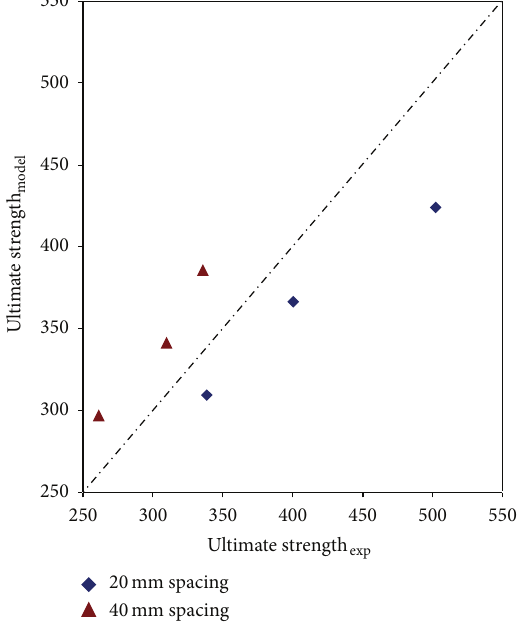
Figure 24: Correlation between experimental and theoretical strength enhancement